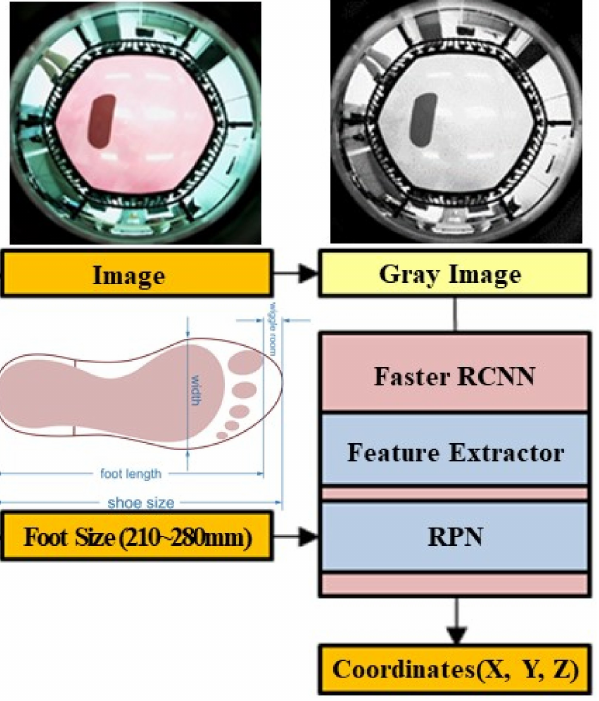
Figure 3. Flow of the 3DFPE-DL algorithm.